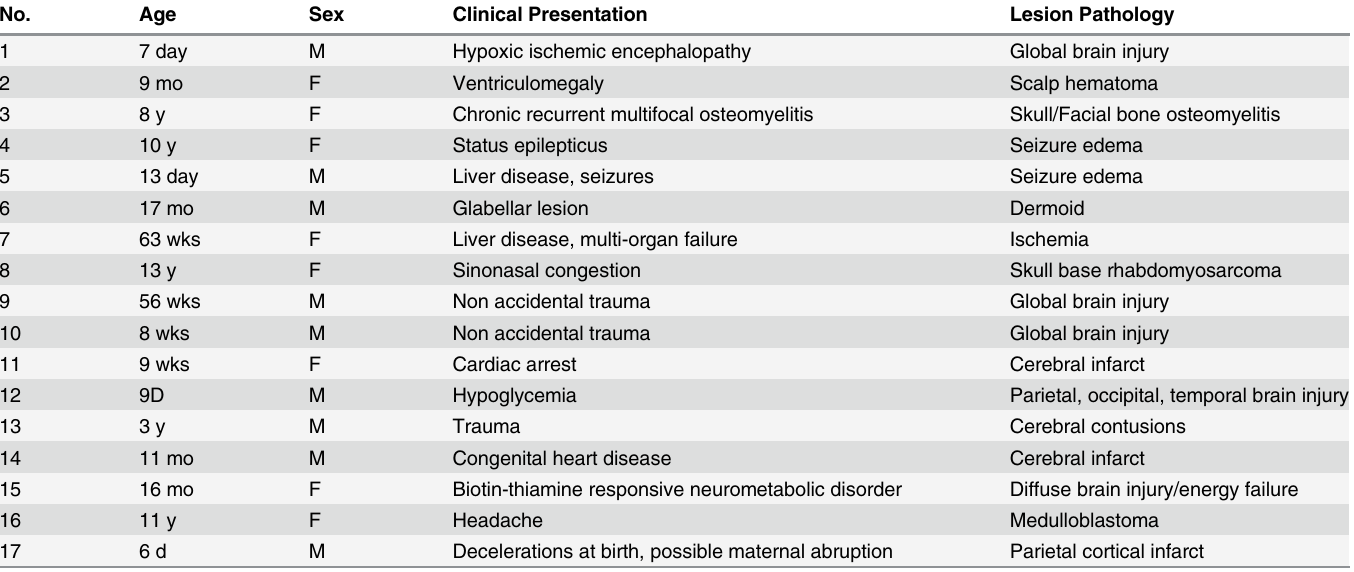
Table 1. Patient demographics, clinical presentation, and specific neuropathology with reduced diffusion. No. Age Clinical